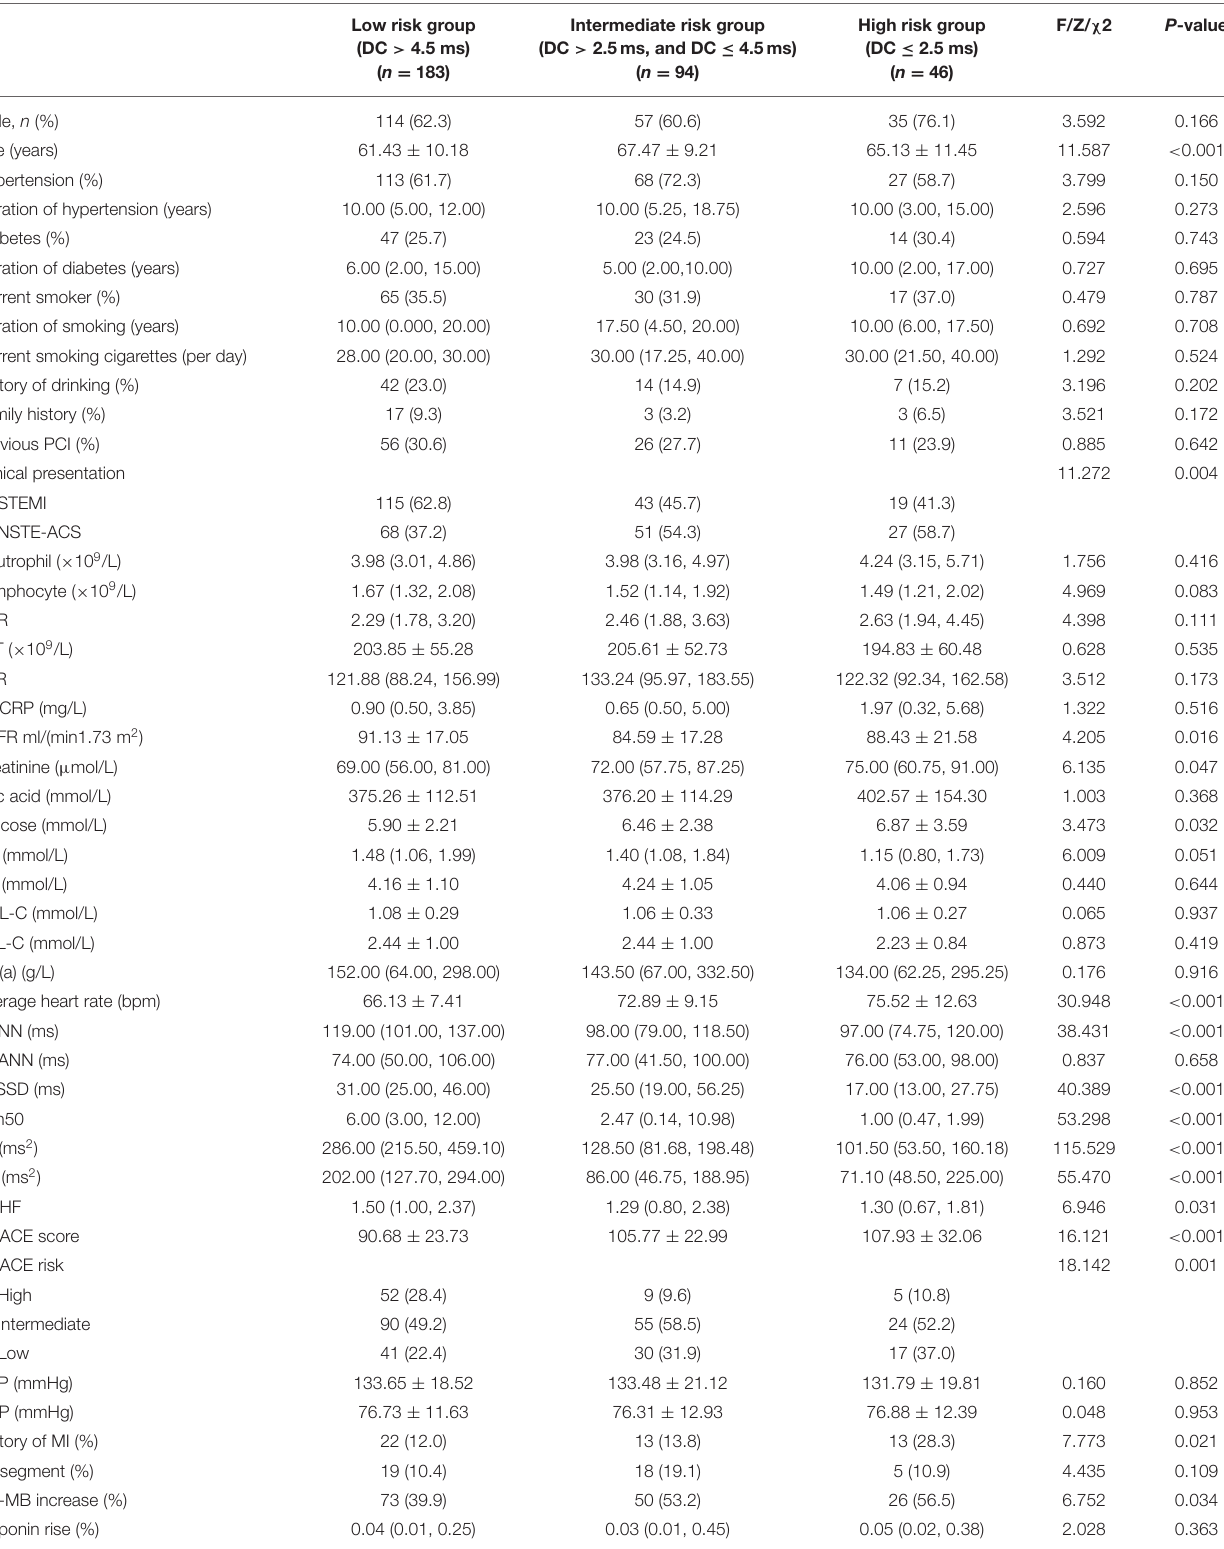
TABLE 1 | Baseline characteristics of the study population categorized by deceleration capacity